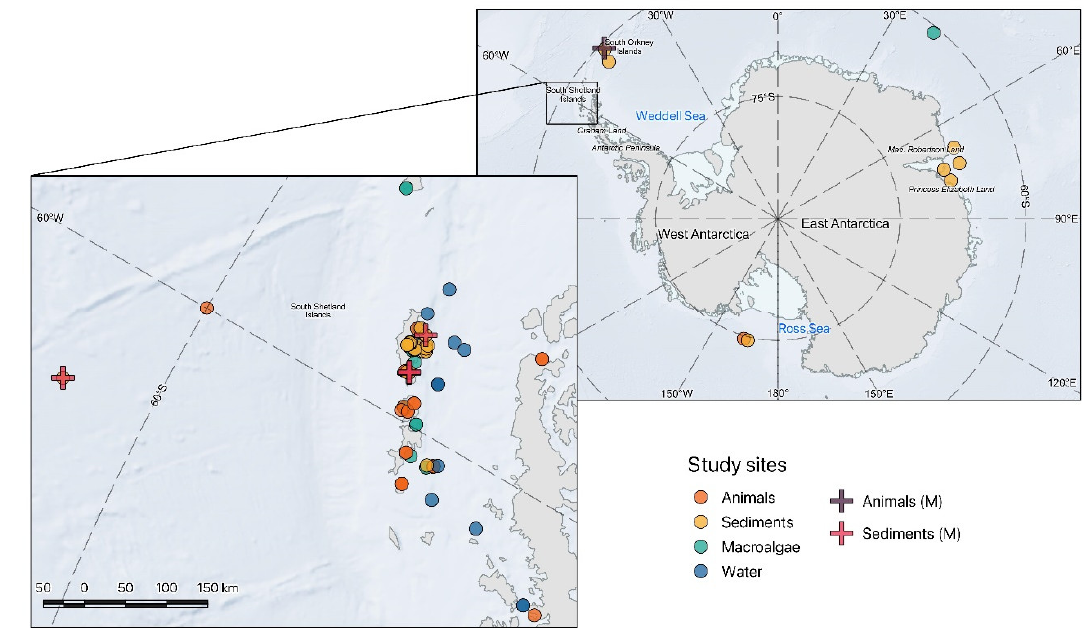
Figure 1. Locations of the fungi identified from different Antarctic marine substrates: animals (orange circle), sediments (yellow circle), macroalgae (green circle), and water (blue circle) based on culture dependent approaches or identified through metagenomic analysis: animals (purple cross) and sediments (pink cross) (for detailed elucidation on the samples where fungal taxa were isolated, and coordinates see Table S1).